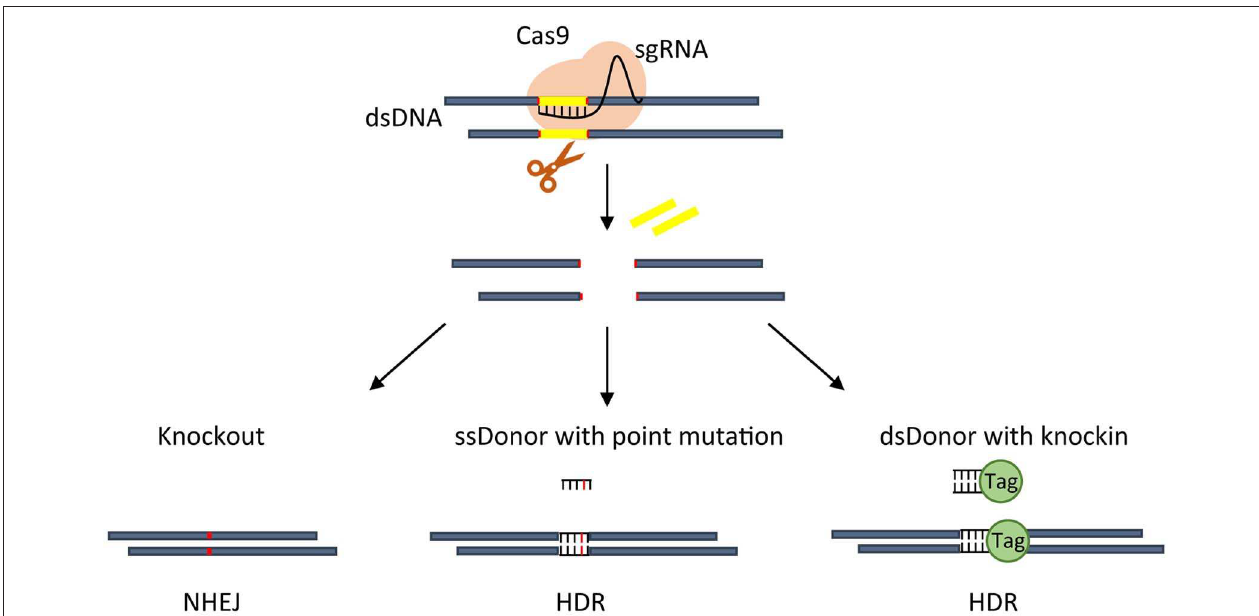
FIGURE 1 | Overview of CRISPR-based approaches. An active CRISPR nuclease Cas9 is directed by sgRNA to make a cut on DNA that, through NHEJ repair, usually create a small indel thus allowing gene knockout (left). CRISPR-Cas9 guided cut, through HDR, can insert point mutation mediated by single strand (ss) donor with point mutation (middle), or generate an in frame knockin by using double strand (ds) donor carrying knockin sequence